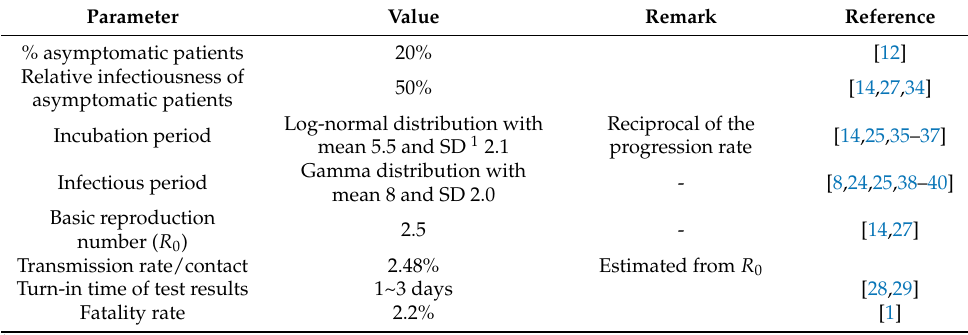
Table 1. Parameters of the ABM simulation and their baseline